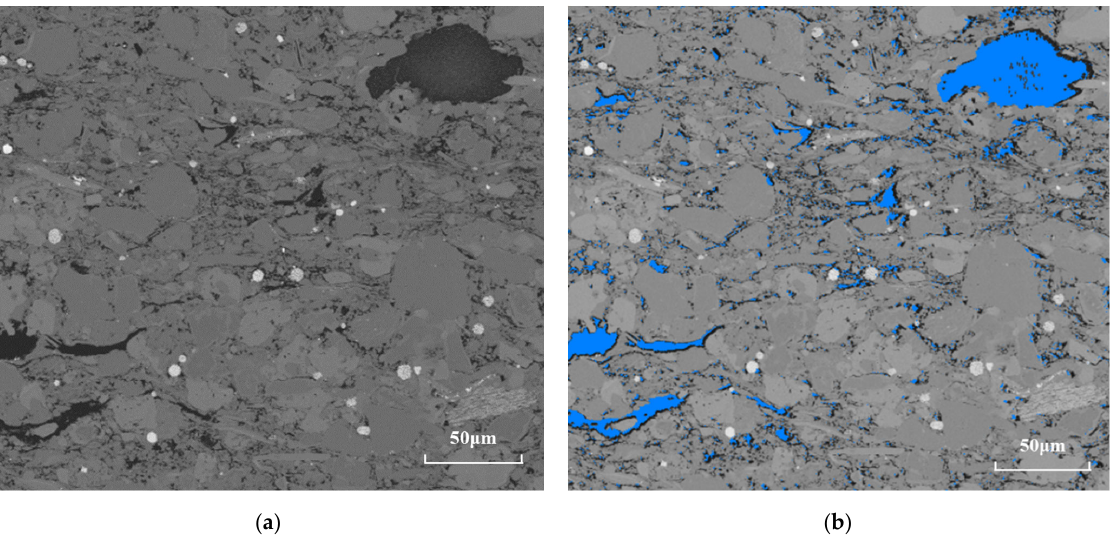
Figure 17. Scanning electron microscope images of the shale matrix of a low-permeability L1 sample with large view stitching. ( a ) Original image. ( b ) Organic matter demarcated as